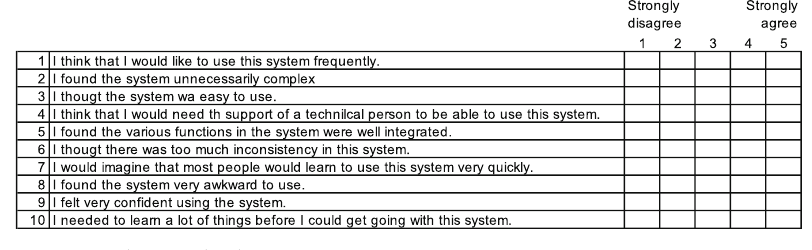
Figure 8. The standard SUS.